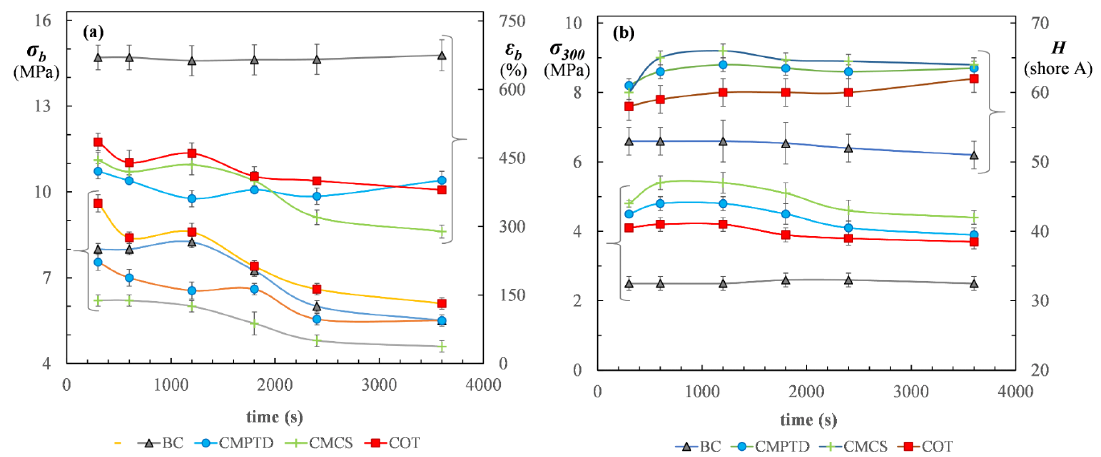
Figure 3. Vulcanization rates for CMPTD, CMCS and COT compounds. ( a ) Breaking load and elongation-at-break vs. vulcanization time; ( b ) load at 300% and hardness H (Shore A) vs. vulcanization time. Experimental results of the reference BC compound is plotted for comparison. Error bars indicate the standard deviation of repeated